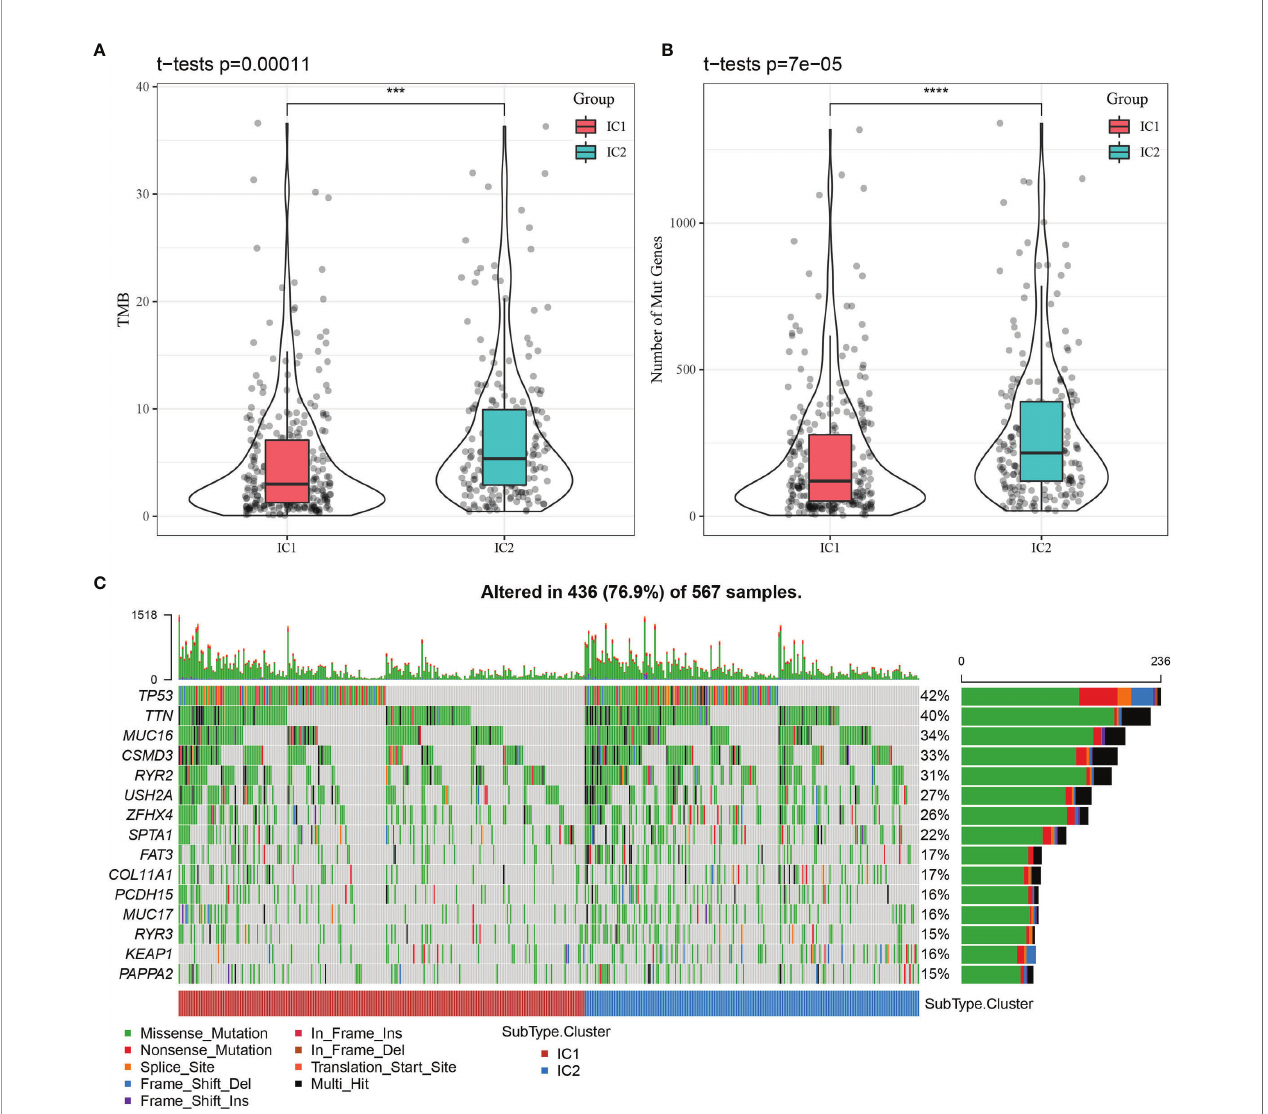
FIGURE 4 | Relationship between tumor mutation burden (TMB) and molecular subtypes. (A) Distribution of TMB for molecular subtype samples. (B) Distribution of the number of mutations for molecular subtype samples. Rank sum test was used to determine the p-value, where ***p < 0.001, ****p < 0.0001. (C) Mutation features of signi fi cantly mutated genes in samples of each molecular